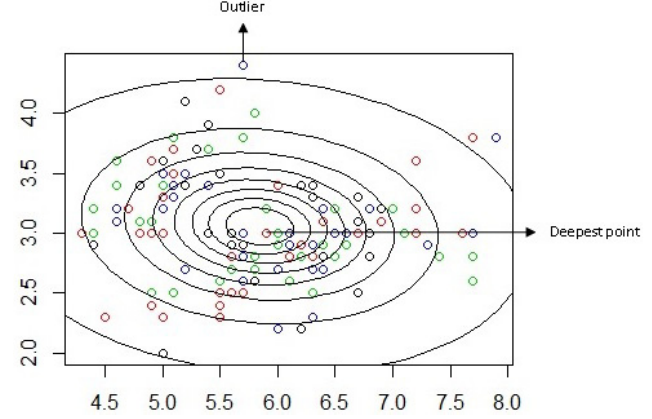
Fig. 1. Mahalanobis depth contours over